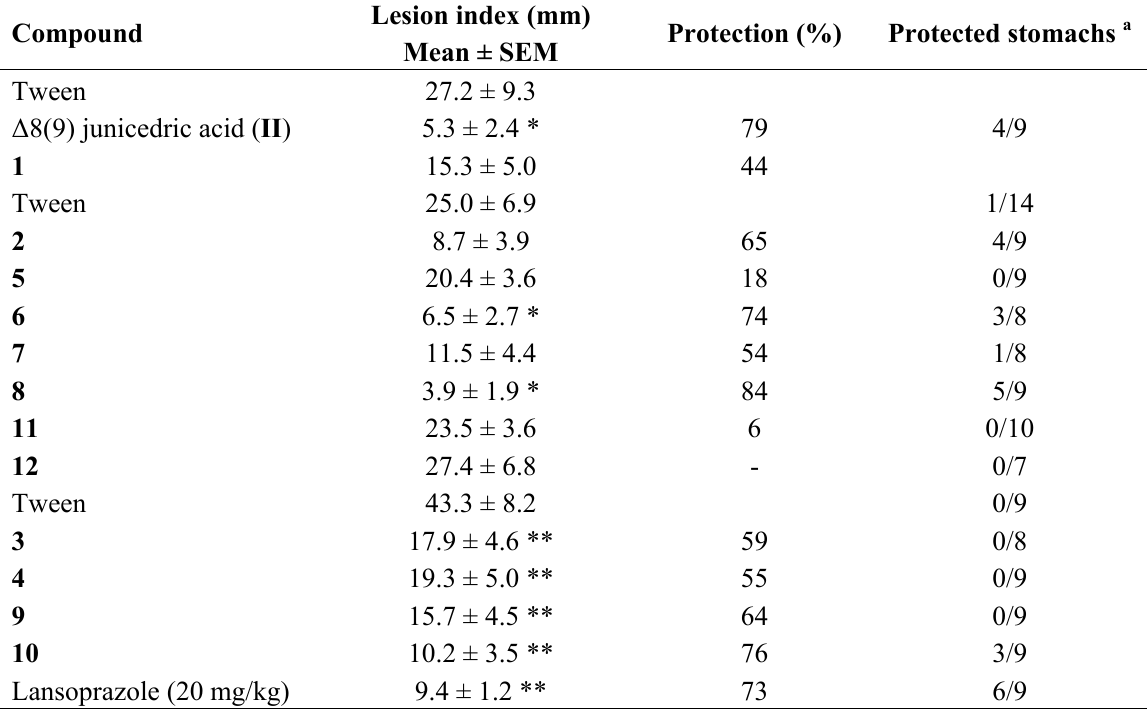
* and **: P < 0.05 different from untreated control (Tween); a Number of stomachs which were completely protected from any visible bleeding. One-way ANOVA with Student-Newman-Keuls post-hoc